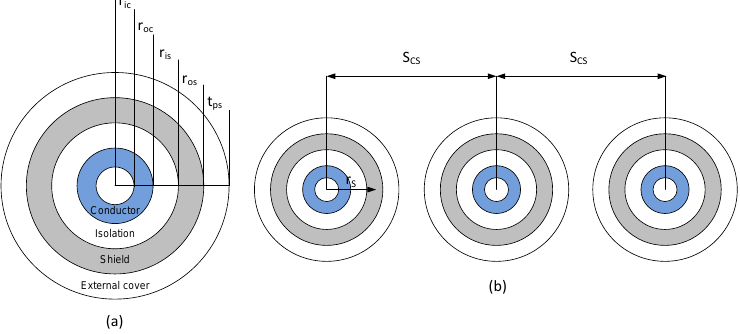
Figure 4. ( a ) Cable composition and ( b ) flat disposal. (r ic ) Internal conductor radius; (r oc ) External conductor radius; (r is ) Internal conductor shield; (r os ) External shield radius; (r s ) Average shield radius; (S CS ) Distance between axes of the conductor and shield; (t ps ) External cover thickness.